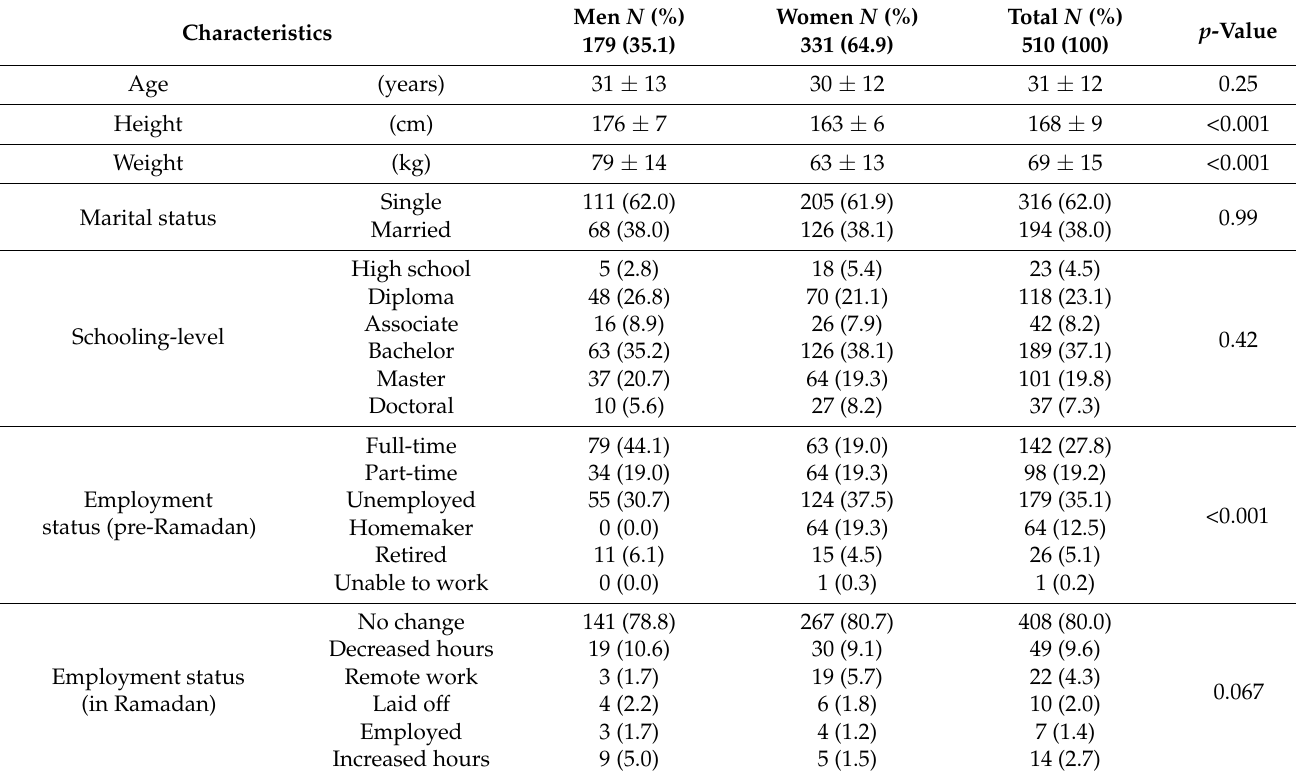
Table 1. Participants’ demographics by